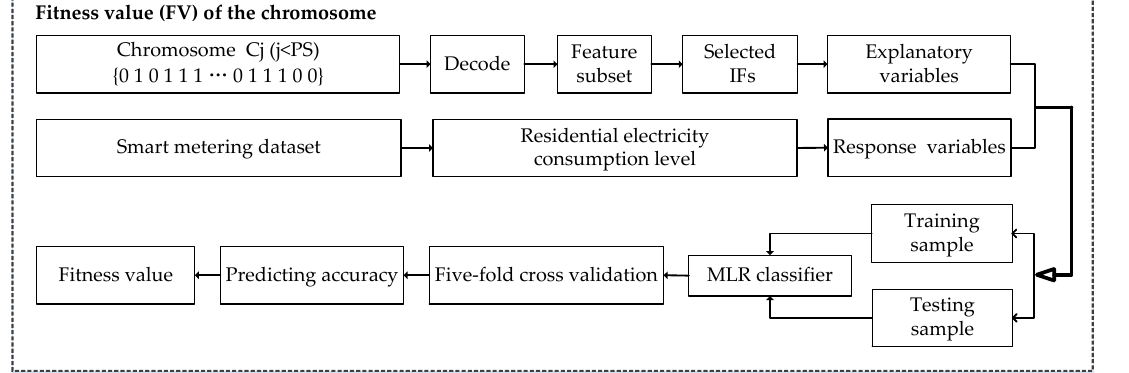
Figure 5. The calculation process of fitness value.